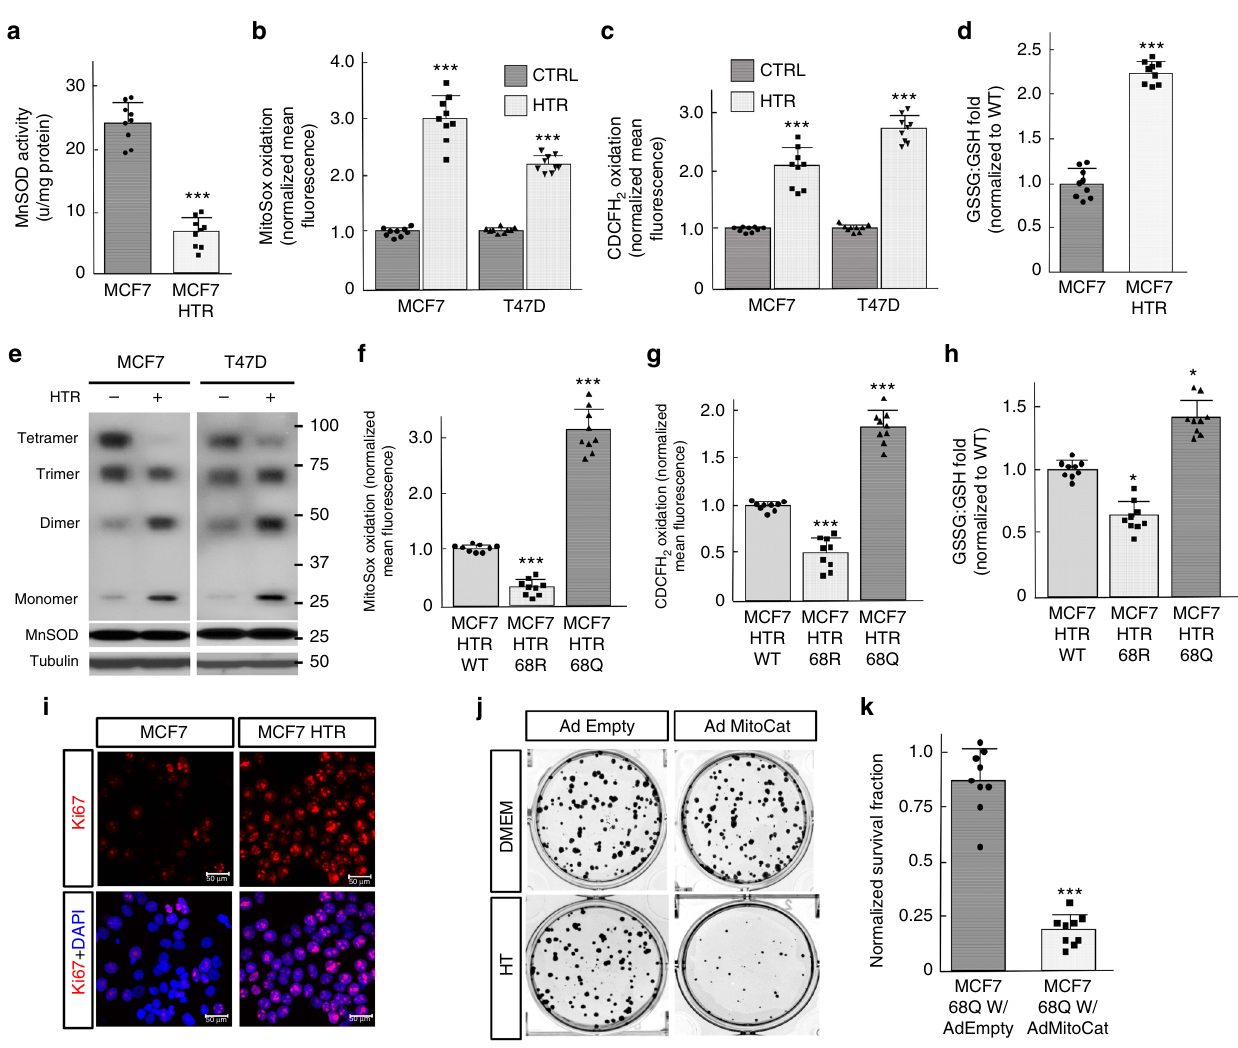
Fig. 7 Hydroxy-Tam exposure increases oxidative stress. a MCF7 and MCF7-HTR whole-cell lysates were used for analysis of total MnSOD activity. b , c MCF7 and MCF7-HTR, and T47D and T47D-HTR whole-cell homogenates, were used to determine: b steady-state levels of O 2 ● − , by MitoSox oxidation; and c H 2 O 2 by CDCFH 2 oxidation. d Glutathione levels in MCF7 and MCF7-HTR whole-cell homogenates. e Semi-native gel analysis of MCF7 and MCF7-HTR, as well as T47D and T47D-HTR cell lysates. f – h Whole-cell homogenates of MCF7-HTR cells expressing MnSOD WT , MnSOD K68Q , or MnSOD K68R were analyzed for: f steady-state levels of O 2 ● − , g H 2 O 2 , and h glutathione levels. i MCF7 and MCF7-HTR cells were stained for Ki-67